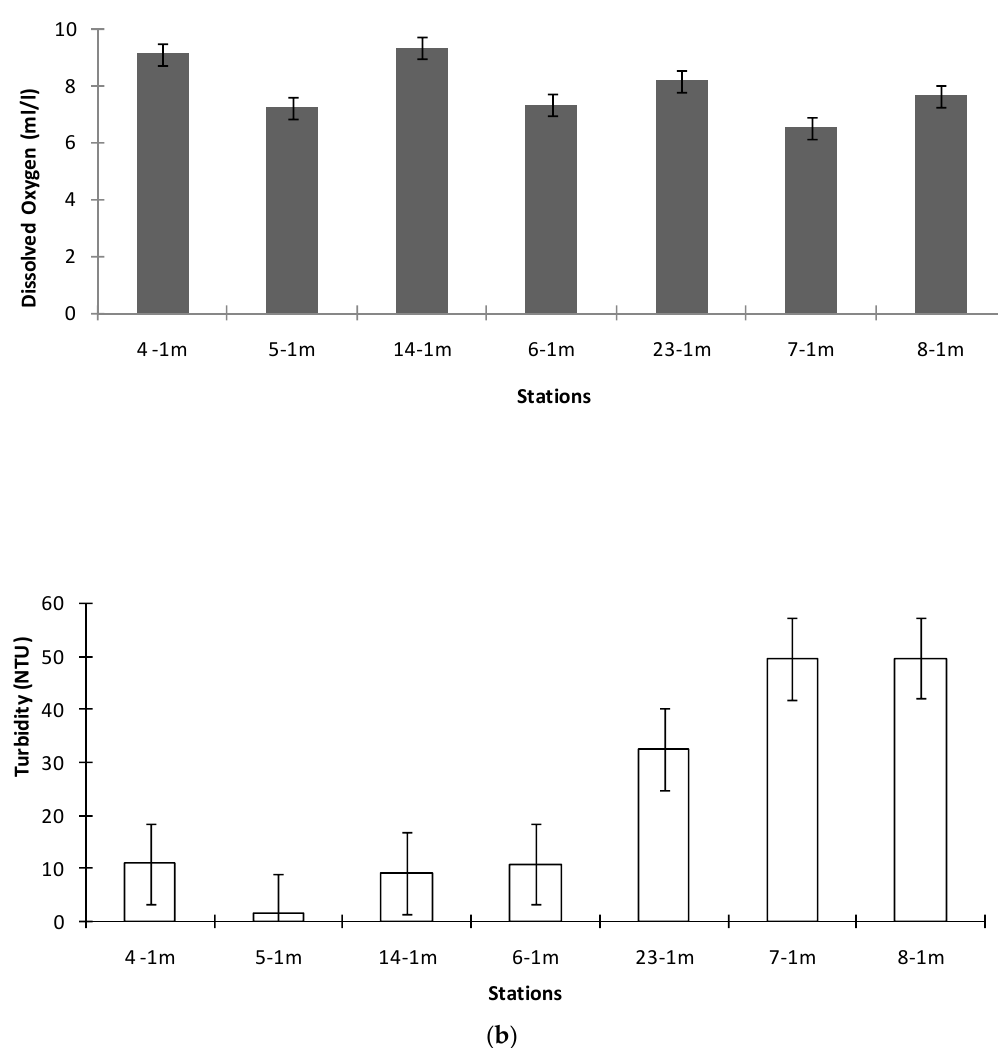
Figure 2. ( a ) Mean values ± S.E. of water temperature and salinity measured along the Kongsfjorden transect from the entrance to the glacier, and vertical profile of the station 4 (0–100 m). ( b ) Mean values ± S.E. of water dissolved oxygen and turbidity measured along the Kongsfjorden transect, from the entrance to the glacier, and vertical profile of the station 4 (0–100 m).